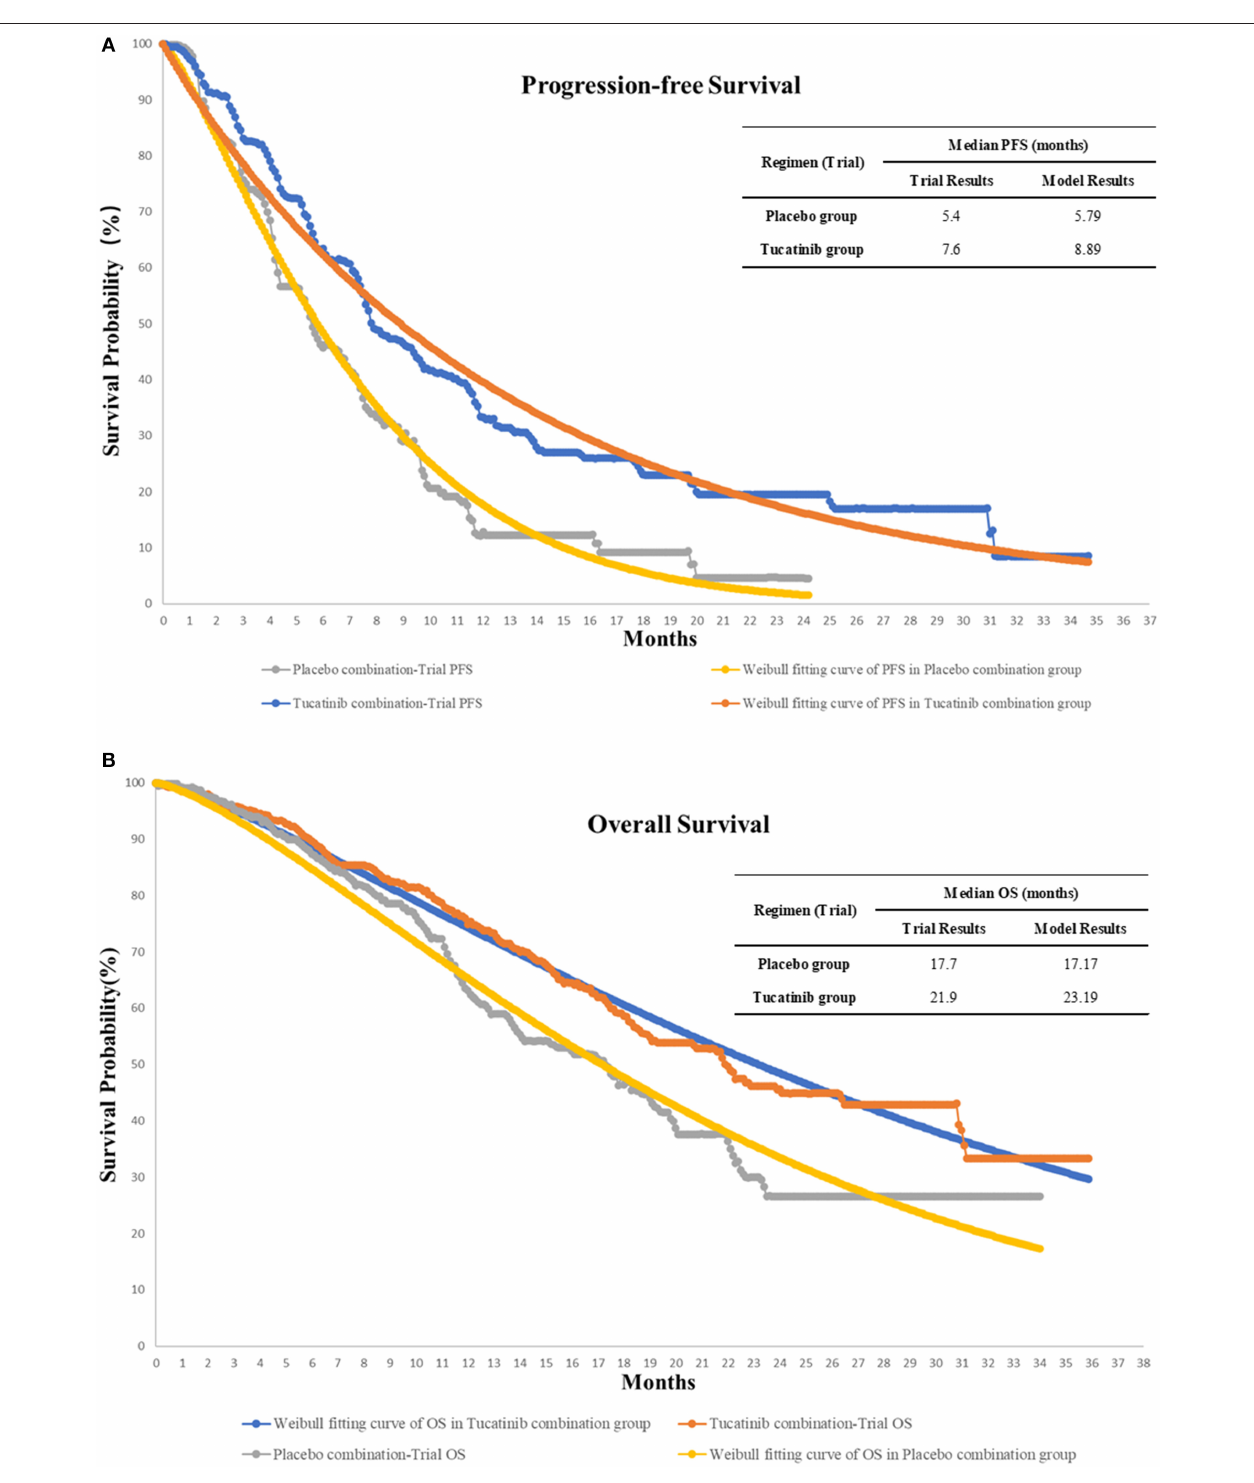
FIGURE 2 | The original Kaplan-Meier PFS (A) and OS (B) curves from the HER2CLIMB trial, Weibull fitting curves, and the validation of our model of treatment strategies for HER2-Positive Metastatic Breast Cancer. OS, overall survival; PFS, progression-free survival.